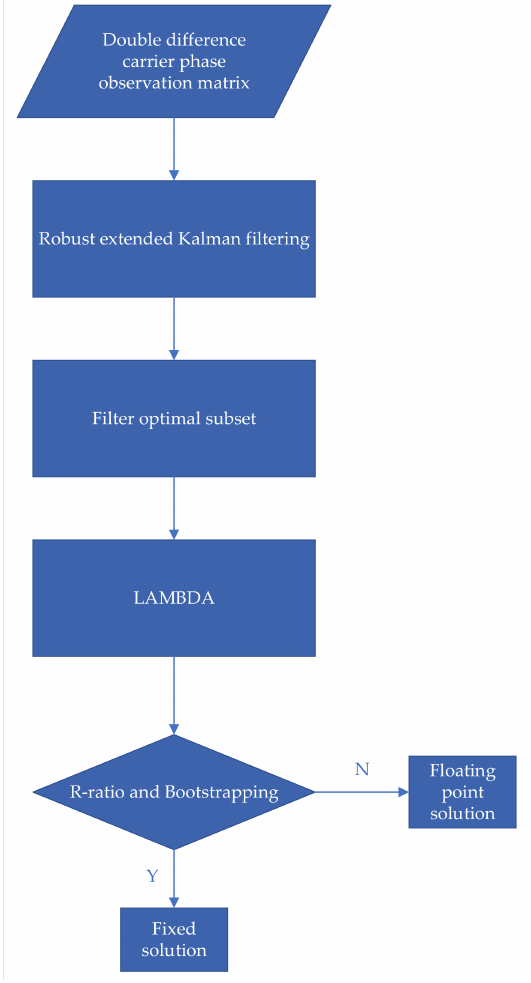
Figure 1. Flow chart of ambiguity resolution steps of network RTK reference